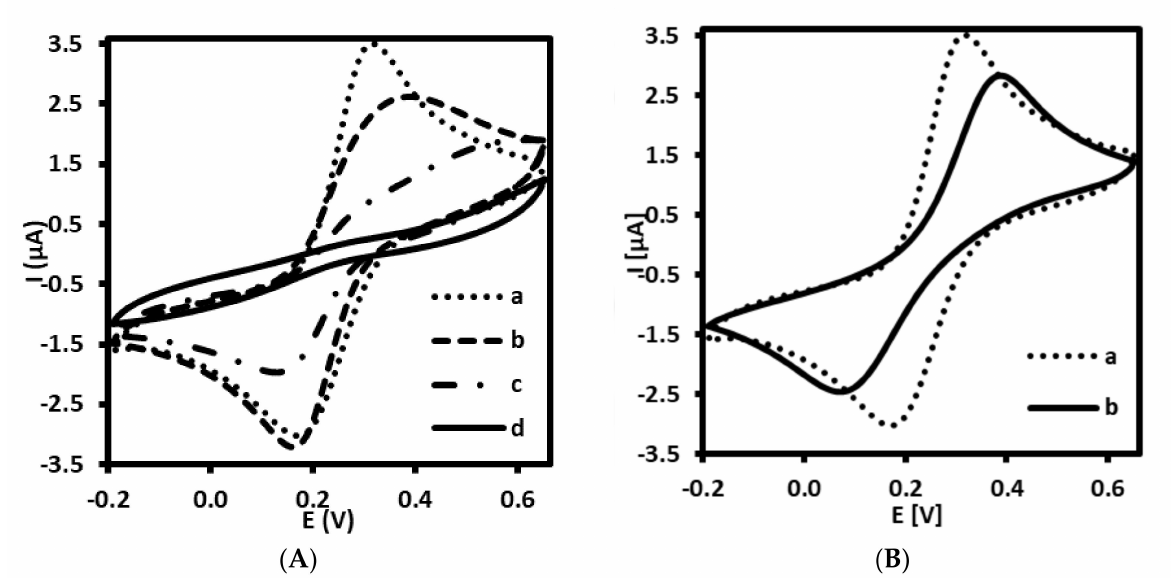
Figure 2. Cyclic voltammograms recorded for ( A ) immunosensor at different stages of fabrication: (a) bare gold elec- trode (Au), (b) Au/4-ATP, (c) Au/4-ATP/AbM-anti-apoB, (d) Au/4-ATP/AbM-anti-apoB/BSA, and ( B ) aptasensor at different stages: (a) bare gold electrode (Au), (b) Au/LDL-Apt, 6MHol. Supporting electrolyte: PBS (pH 7.4) with 1 mM [Fe(CN) 6 ] 3 − /4 −